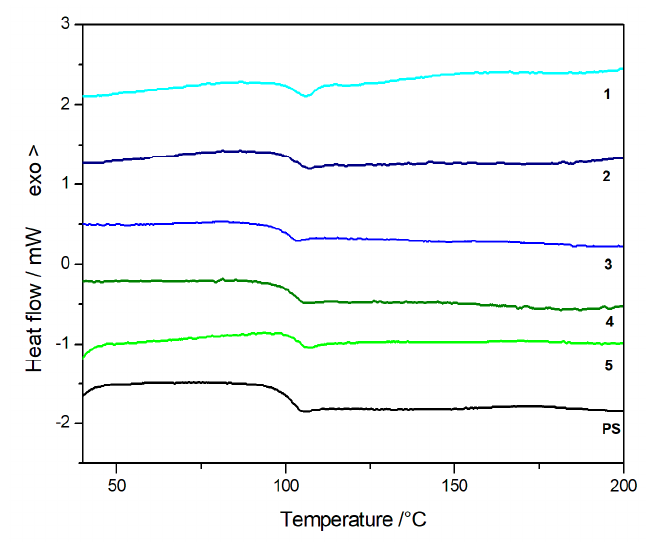
Figure 12. Di ff erential scanning calorimetry curves for PS and PS / POSS Figure 12. Differential scanning calorimetry curves for PS and PS/POSS nanocomposites.